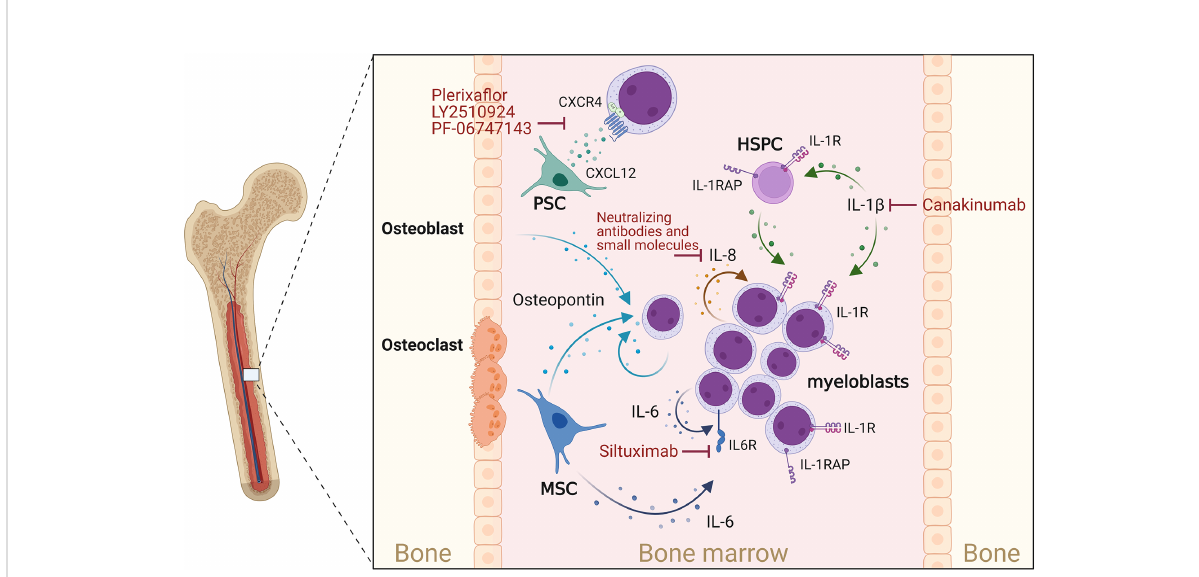
FIGURE 1 Cytokines supporting AML progression. Osteoblasts, myeloblasts and mesenchymal stromal cells (MSCs) secrete osteopontin. This in turn promotes AML cell proliferation and disease progression. CXCL12 is mainly secreted by perivascular stromal cells (PSCs), and osteoblasts and promotes growth and survival of AML blasts cell via the chemokine receptor CXCR4. IL-1 b acts on myeloblasts and HSPCs, which express the IL-1 receptor (IL-1R) as well as the IL-1 receptor accessor protein (IL-1RAP), thereby enhancing IL-1 b production, AML cell proliferation and survival. IL-1 signaling can be blocked by Canakinumab, a human monoclonal antibody targeting IL-1 b . IL-8 is constitutively produced by AML myeloblasts and acts in an autocrine way. MSCs and myeloblasts are potent sources of IL-6, which can be blocked by IL-6-blocking antibodies such as Siltuximab. Created with